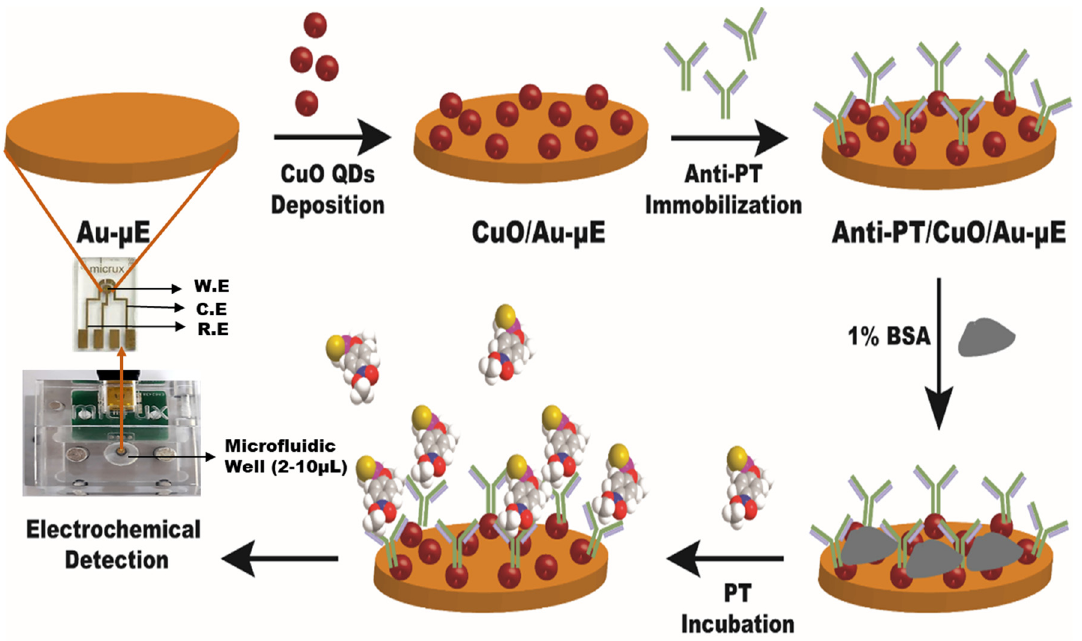
Figure 1. Graphical representation of successive fabrication steps of Anti-PT/CuO/Au-µE (W.E— working electrode; C.E—counter electrode; R.E—reference electrode).